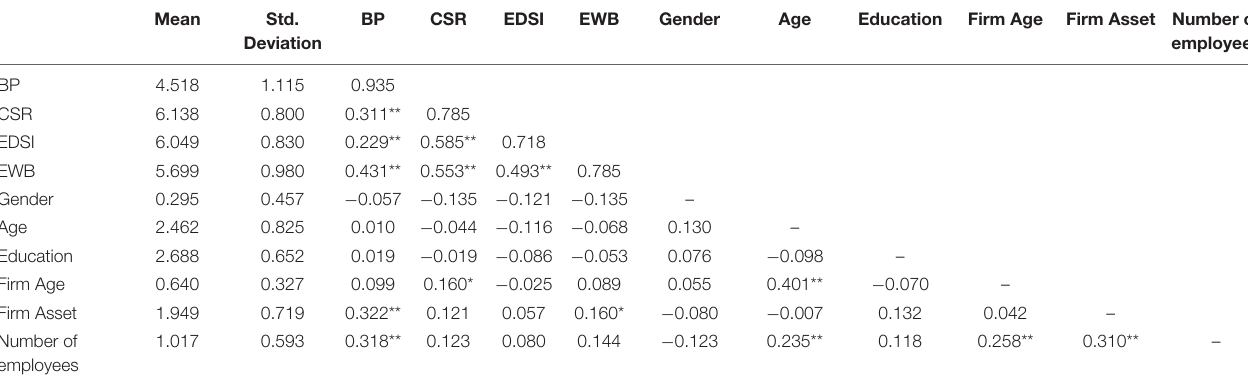
TABLE 2 | The results of correlation matrix and descriptive